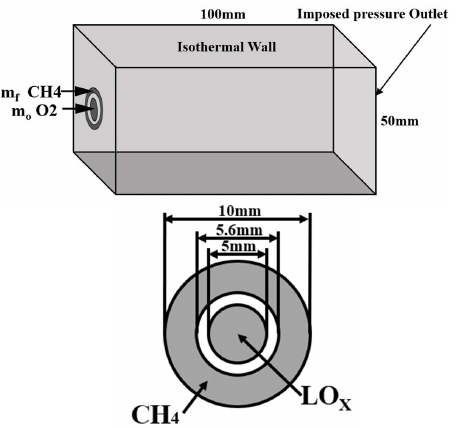
Figure 2. Schematic of the computational domain and the boundary